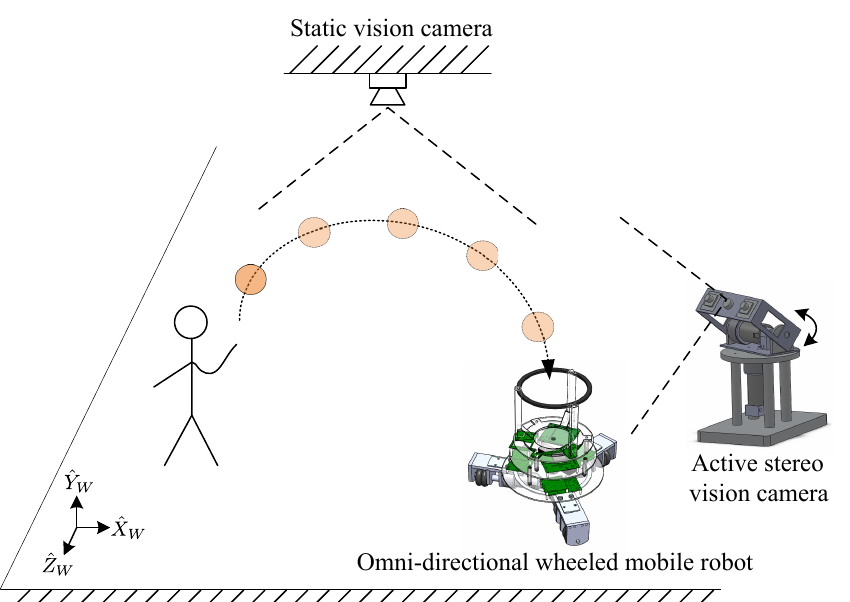
Figure 1. Schematic overview of the proposed